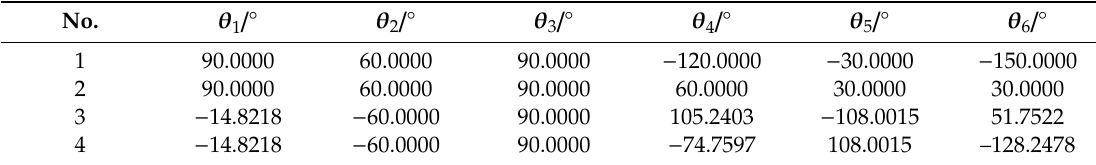
Table 13. Four inversely solved joint angle sets.